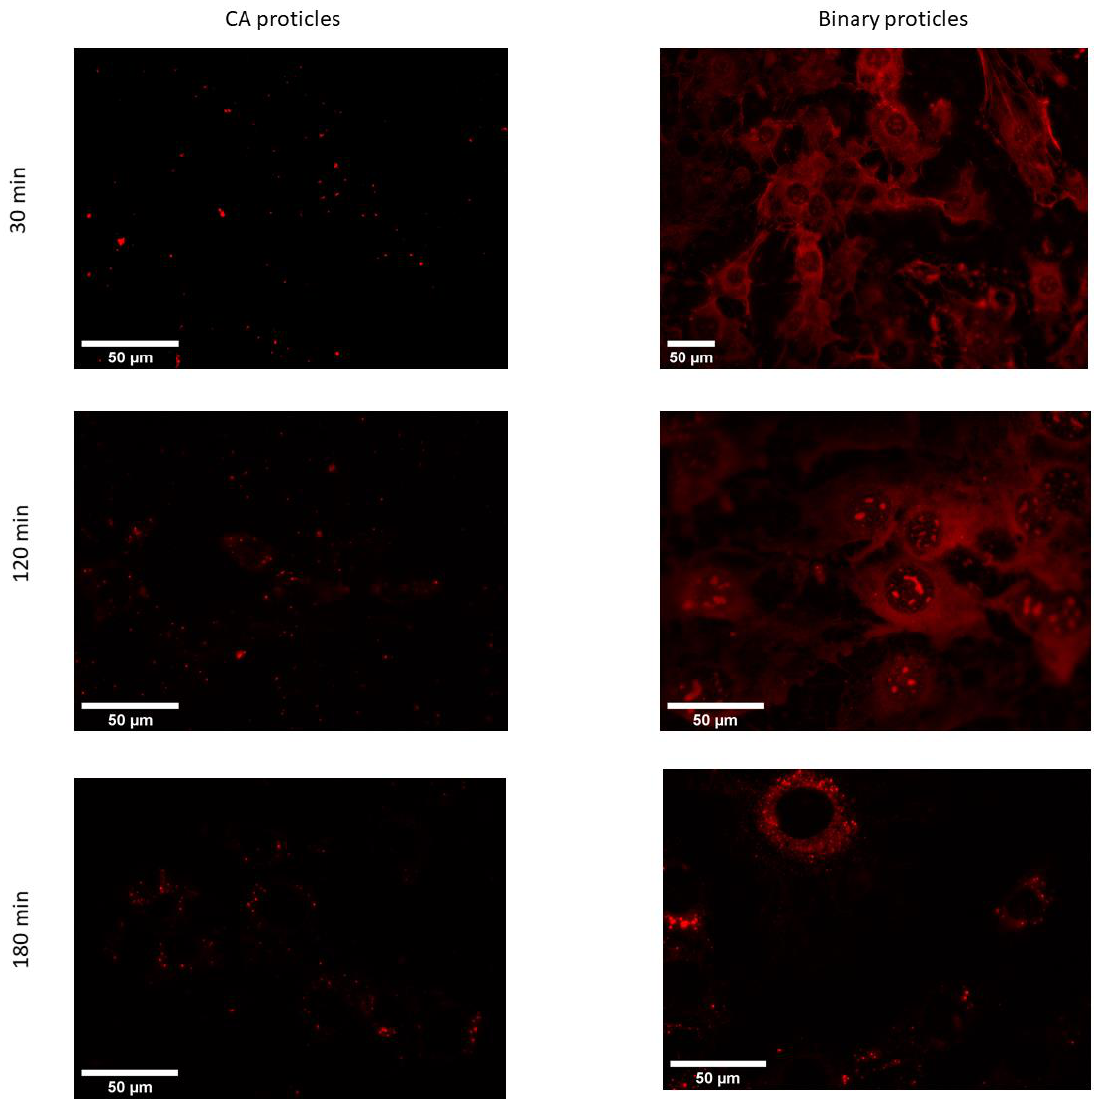
Figure 10. Fluorescence microscopic images of living 3T3-L1 cells at 37 °C transfected with CA- proticles (protamine:CA molar ratio of 1:10) and binary proticles (red) at 400 nM (30 min, 120 min, and 180 min post-transfection).